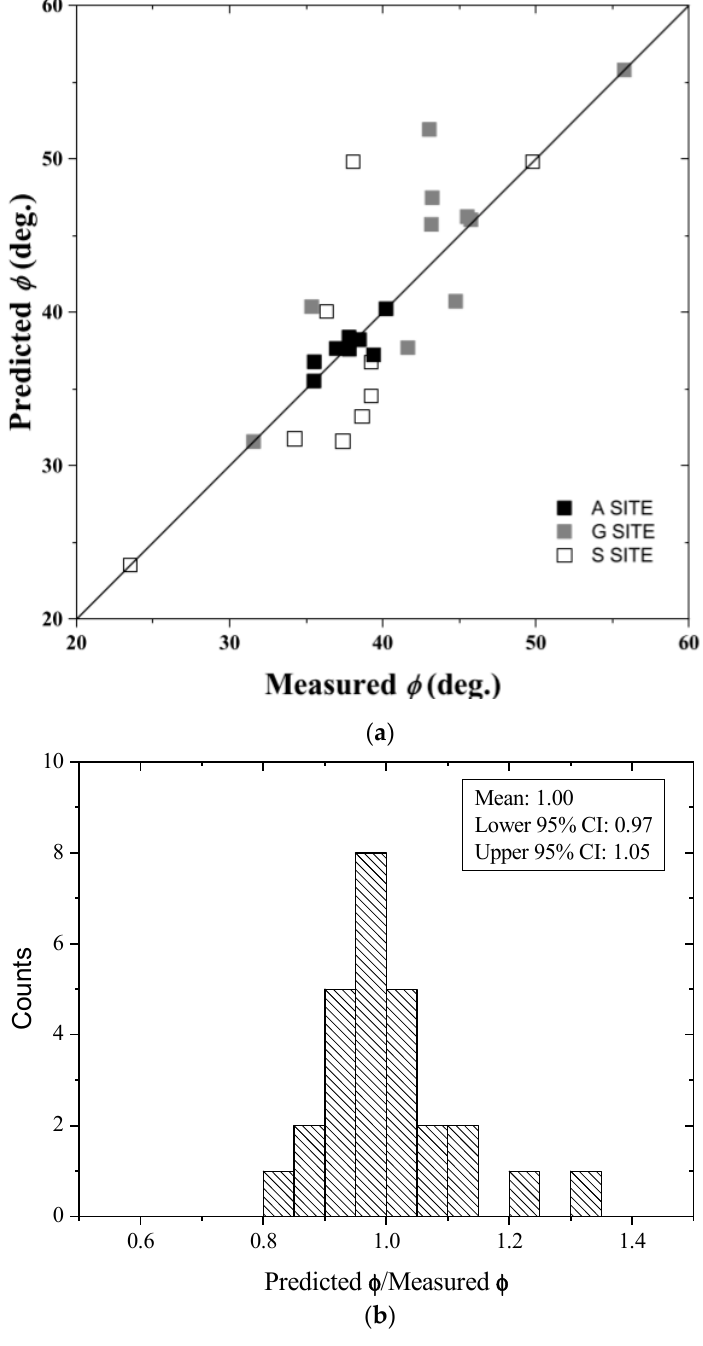
Figure 8. ( a ) Predicted friction angle with measured friction angle; ( b ) histogram of the predicted friction angle over measured friction angle.